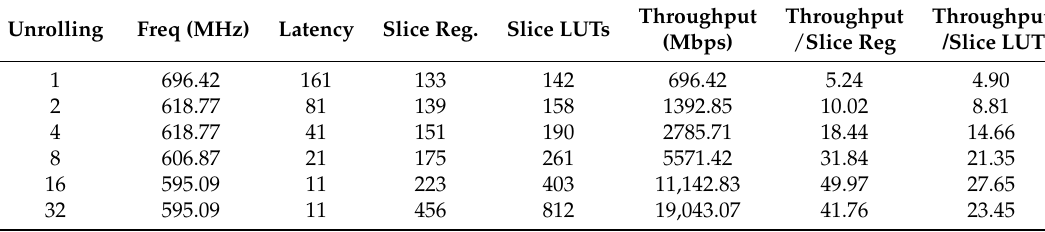
Table 8. Grain-80 synthesis results (Xilinx Virtex7, device XC7vx330t).